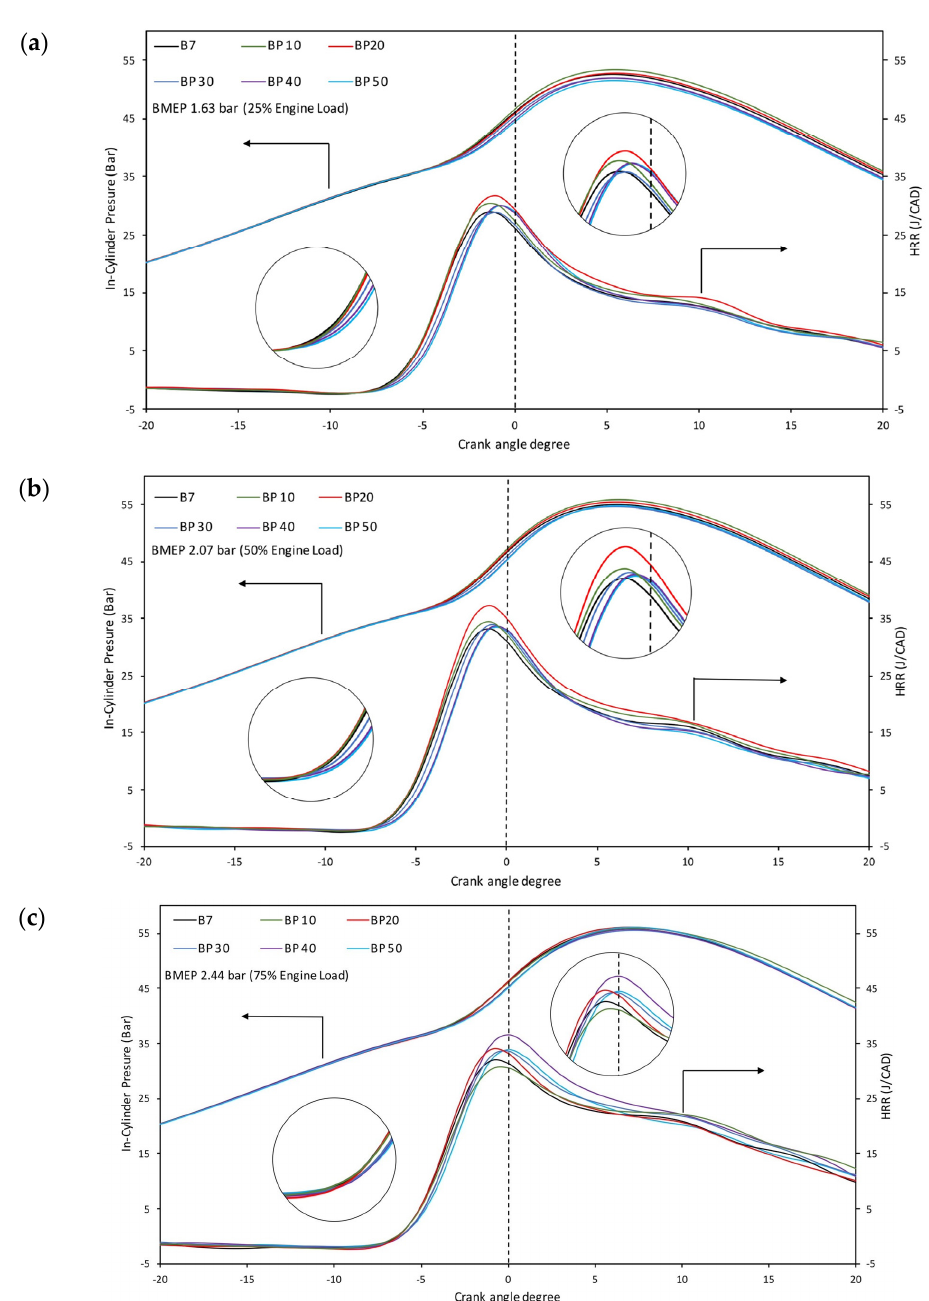
Figure 2. In-cylinder pressure profile and heat release rate in the combustion process with ( a ) a BMEP of 1.63 bar (25% engine load); ( b ) a BMEP of 2.07 bar (50% engine load); and ( c ) a BMEP of 2.44 bar (75% engine load).